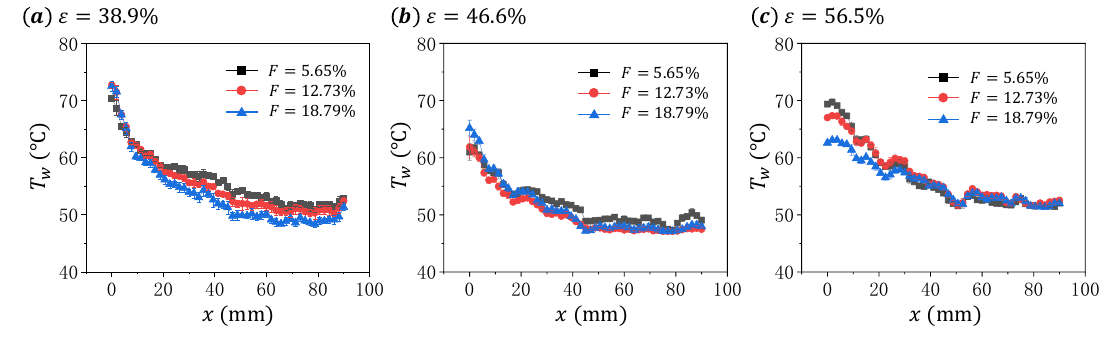
Figure 4. The distribution of surface temperature T w along the central line of the test sample for different blowing ratio F at same porosity ε : ( a ) ε = 38.9%, ( b ) ε = 46.6%, and ( c ) ε =